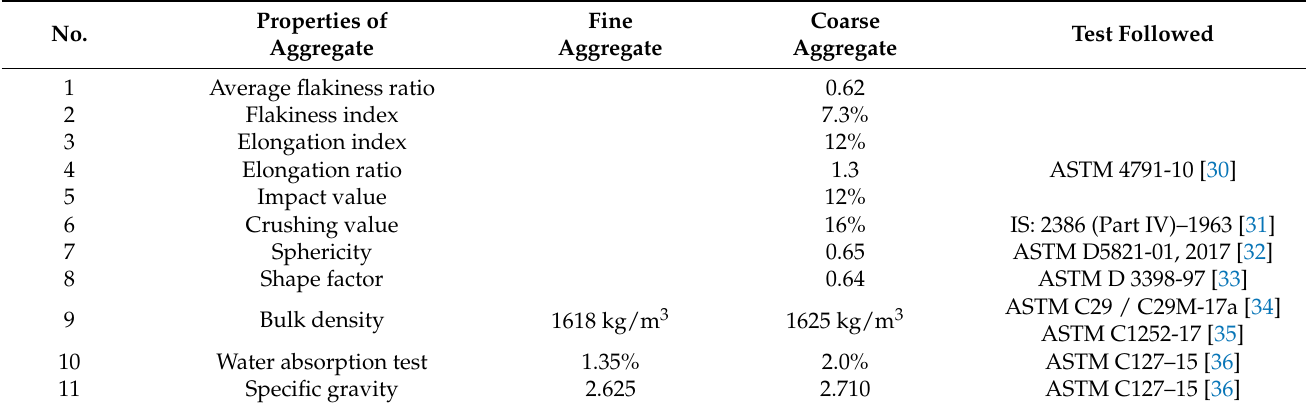
Table 2. Properties of sand and stones.